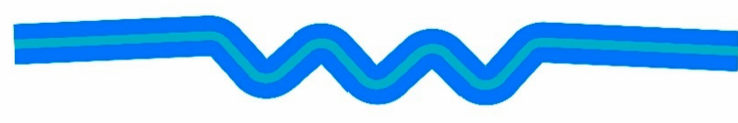
Figure 7. The schematic diagram of the permanent micro-bending